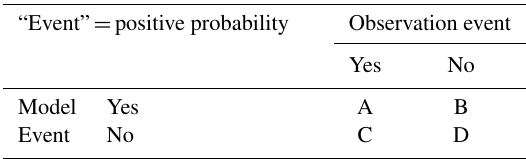
Table 1. Contingency table. “Event” = positive probability Observation event